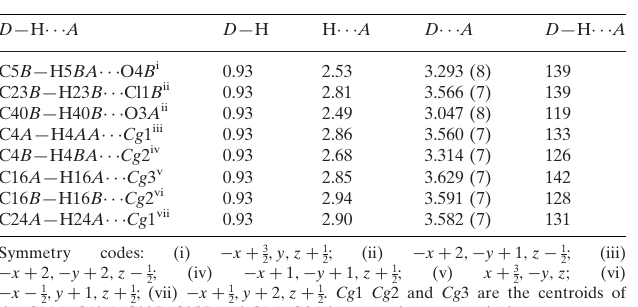
Hydrogen-bond geometry (A˚ , (cid:3)